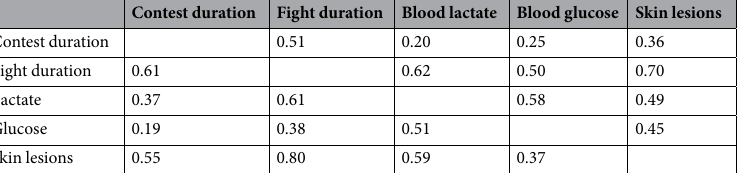
Table 1. Proxy measures of contests costs. Pearson correlation coefficients between various proxy measures of contest costs for contest 1 (values above the diagonal) and contest 2 (values below the diagonal). All correlations are significant at P < 0.001.